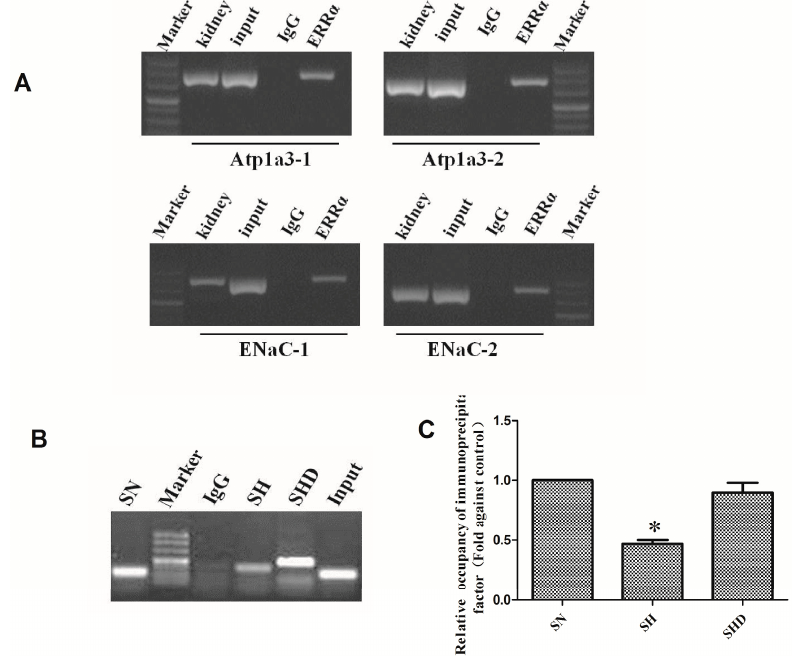
Figure 4. ERR α bound to Na + /K + -ATPase ( Atp1a ) and ENaC promoters in the kidney of the SS rats. ( A ) CHIP assay showing ERR α binding to the Atp1a and the ENaC promoters; ( B ) CHIP assay showing the relative binding capacity of the immunoprecipitated ERR α to the ENaC promoter in DS rats; ( C ) relative binding capacity of immunoprecipitated factor. Data were estimated by 2 ˆ ( C mock ´ C specific ), and normalized with input, * p < 0.001, compared with SN and SHD groups. The SN group was used as the control.